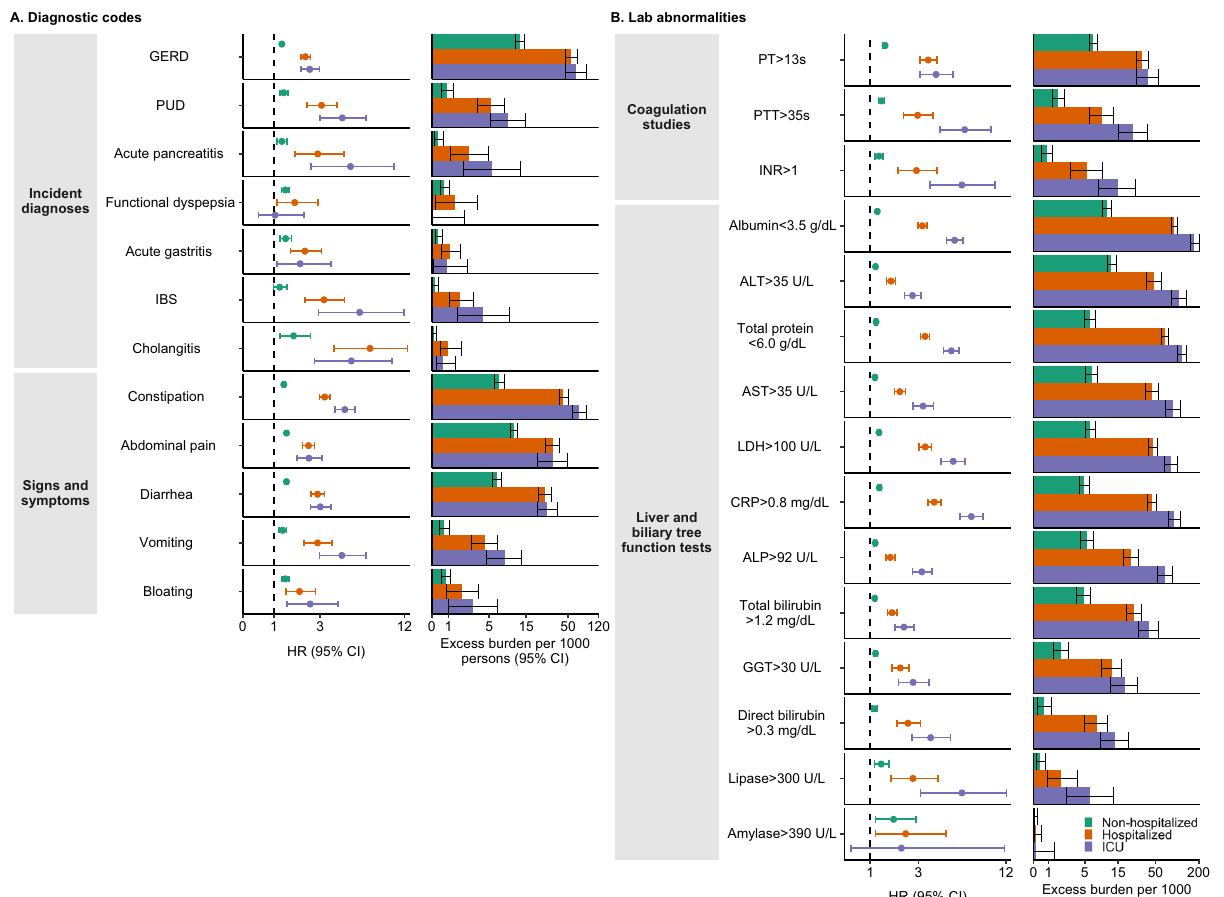
Fig. 4 | Risks and 1-years burdens of incident post-acute COVID-19 gastro- intestinal outcomescomparedwith the contemporary controlcohort by care setting of the acute infection. Risks and burdens were assessed at 1-year in mutually exclusive groups comprising non-hospitalized individualswith COVID-19 (green),individualshospitalizedforCOVID-19(orange)andindividualsadmittedto intensive care for COVID-19 during the acute phase ( fi rst 30d)of COVID-19 (blue). Outcomes were ascertained 30 d after the COVID-19-positive test until the end of follow-up. The contemporary control cohort served as the referent category. Within the COVID-19 cohort, non-hospitalized ( n = 131,915), hospitalized ( n = 16,764), admitted to intensive care ( n = 5389) and contemporary control cohort ( n = 5,606,761). Panel A describes the risks and burdens of incident